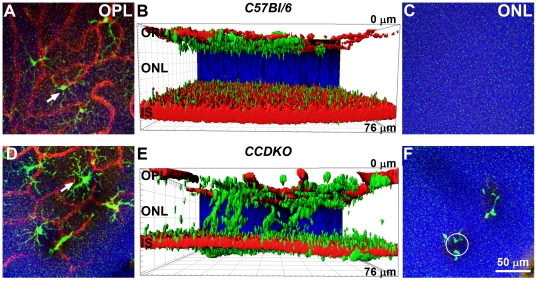
Microglia are recruited to the primary retinal lesions in the outer retina of CCDKO mice.Confocal maximum projection images of a subset of images at different depth of the z-stack (A,C,D,F) and images of 3D-reconstructions (IMARIS) of corresponding complete z-stacks (B,E). Z-stack images were taken from the inferior area of retinal flat mount preparations from CCDKO and C57Bl/6 mice at 2 months of age. The samples were labeled with Tritc-lectinB4 (vascular marker, red), Iba1 (microglia marker, green) and DAPI as a nuclear counter stain (blue). OPL: outer plexiform layer, ONL: outer nuclear layer, IS: inner segments. (A+D) At the level of OPL ramified microglia (green) are located between vessels of the deep capillary plexus (red). Microglia of CCDKO mice (white arrows, D) show a slightly bigger cell bodies than those in C57Bl/6 mice (A). Microglia were also observed in the outer retina of CCDKO mice in the 3D Imaris reconstruction (E) and in confocal z-projections from the outer retina (F) while they were not observed in the outer retina of C57Bl/6 mice (B, C). microglia in the outer retina of CCDKO mice surround circular lesions (F, white circle) that may correspond well with the disciform shape of autofluorescent lesion observed in AF-SLO fundus images.